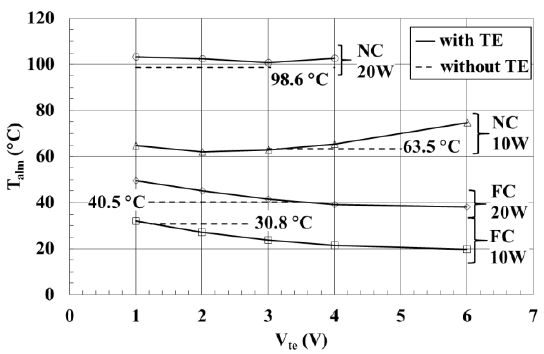
Figure 14. Comparison of surface temperature of aluminum block with and without TE.